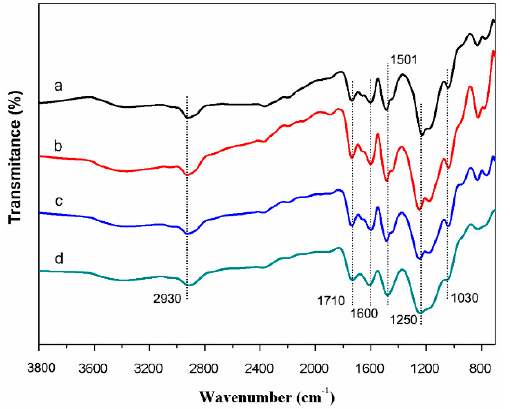
Figure 6. FT-IR spectra of ( a ) control and ( b-d ) precursors in 40 wt % ZnCl 2 solution using ( b ) microwave, ( c ) ultrasound, and ( d ) UV irradiation, respectively.